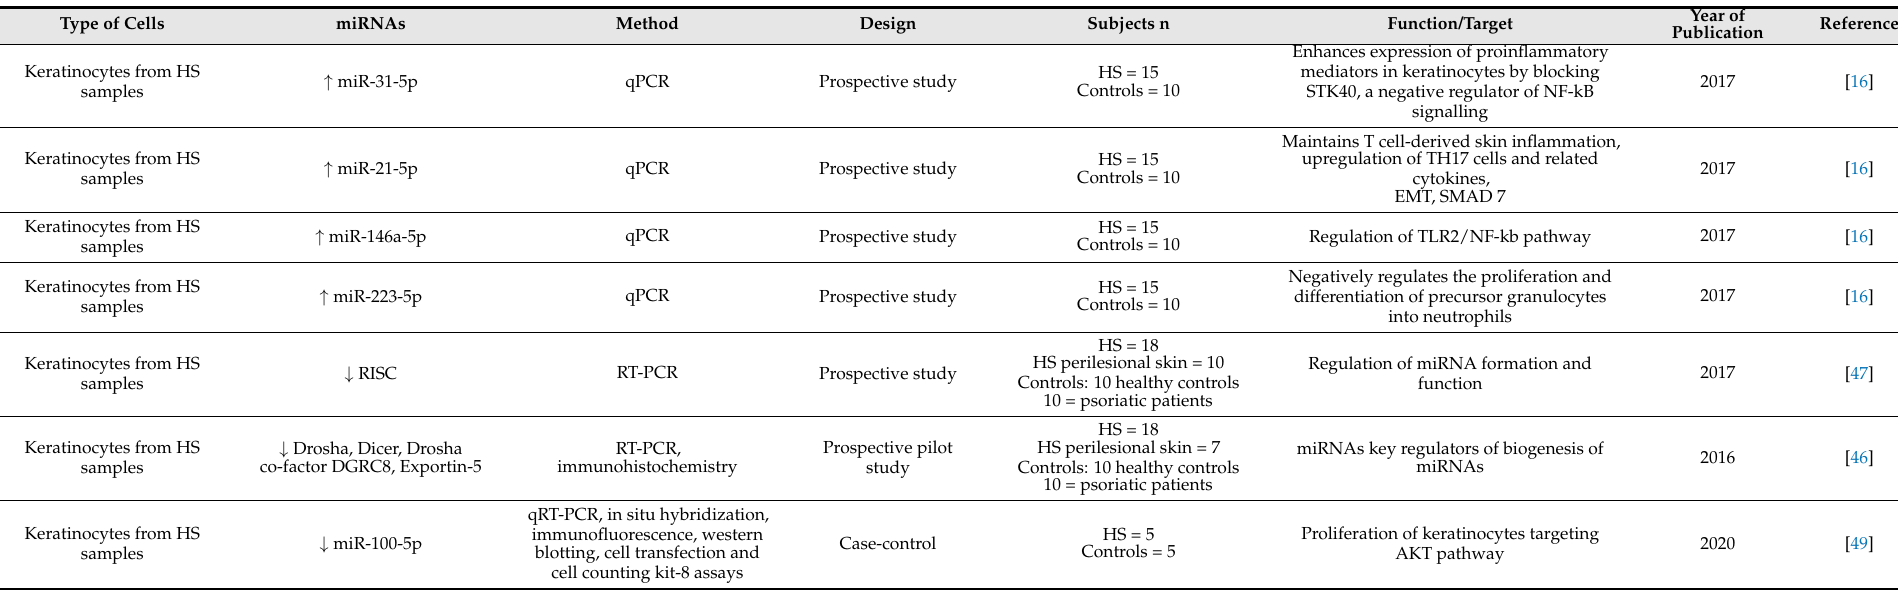
Table 2. MiRNAs, type of cells, method, design, number of subjects, function/targets, year of publication and final effect on inflammation in